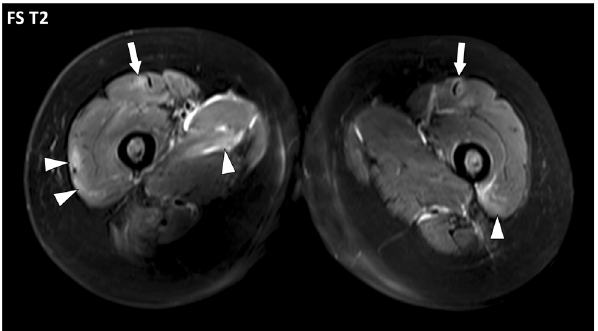
Fig. 16 Axial fat-suppressed T2-weighted image of the thighs of a 49-year-old female with systemic lupus erythematosus, antiphospholipid syndrome and normal CPK. Multiple foci of in- creased signal intensity of the fascial system are depicted and they are all located at the periphery of the muscles near the deep fasciae (arrowheads) or near the fibro-muscular interfaces (arrows) suggesting involvement of the